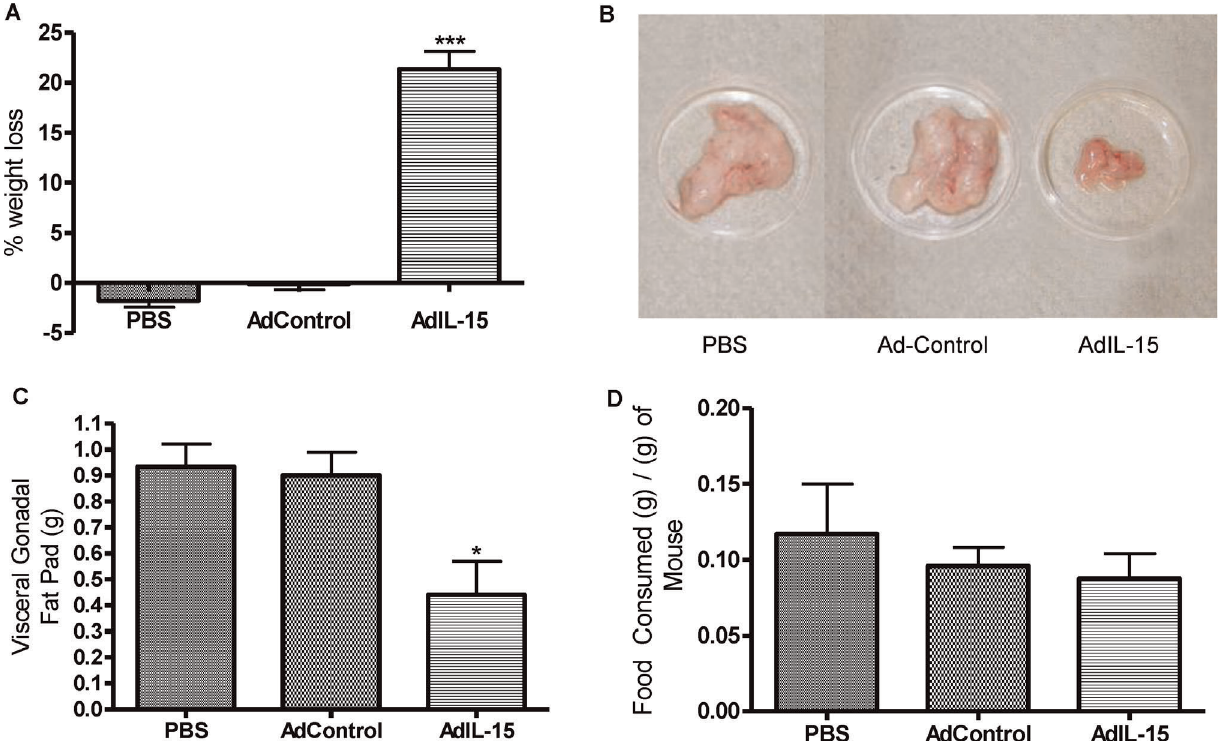
Figure 4. IL-15 induces weight loss independent of lymphocytes and in the absence of the common gamma chain ( c c). ( A ) Percentage of weight loss represented as a bar graph. ( B ) Picture shows excised visceral gonadal fat taken from representative female naı¨ve, Ad-Control, and AdIL-15 treated RAG2 2 / 2 c c 2 / 2 mice. ( C ) Visceral gonadal fat pad in grams shown as a bar graph (n=5 per group). ( D ) Food consumed per gram of mouse monitored for 5 consecutive days (n=5 per group). *P , 0.05, ***P ,